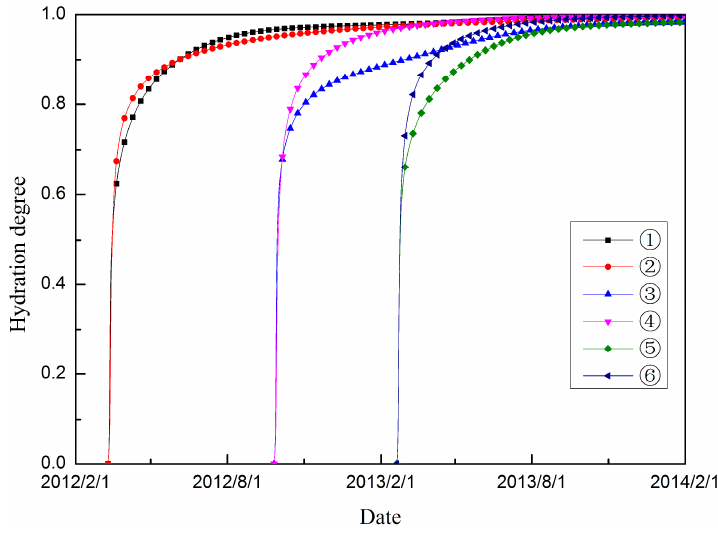
Figure 18. Hydration degree histories of different typical points.